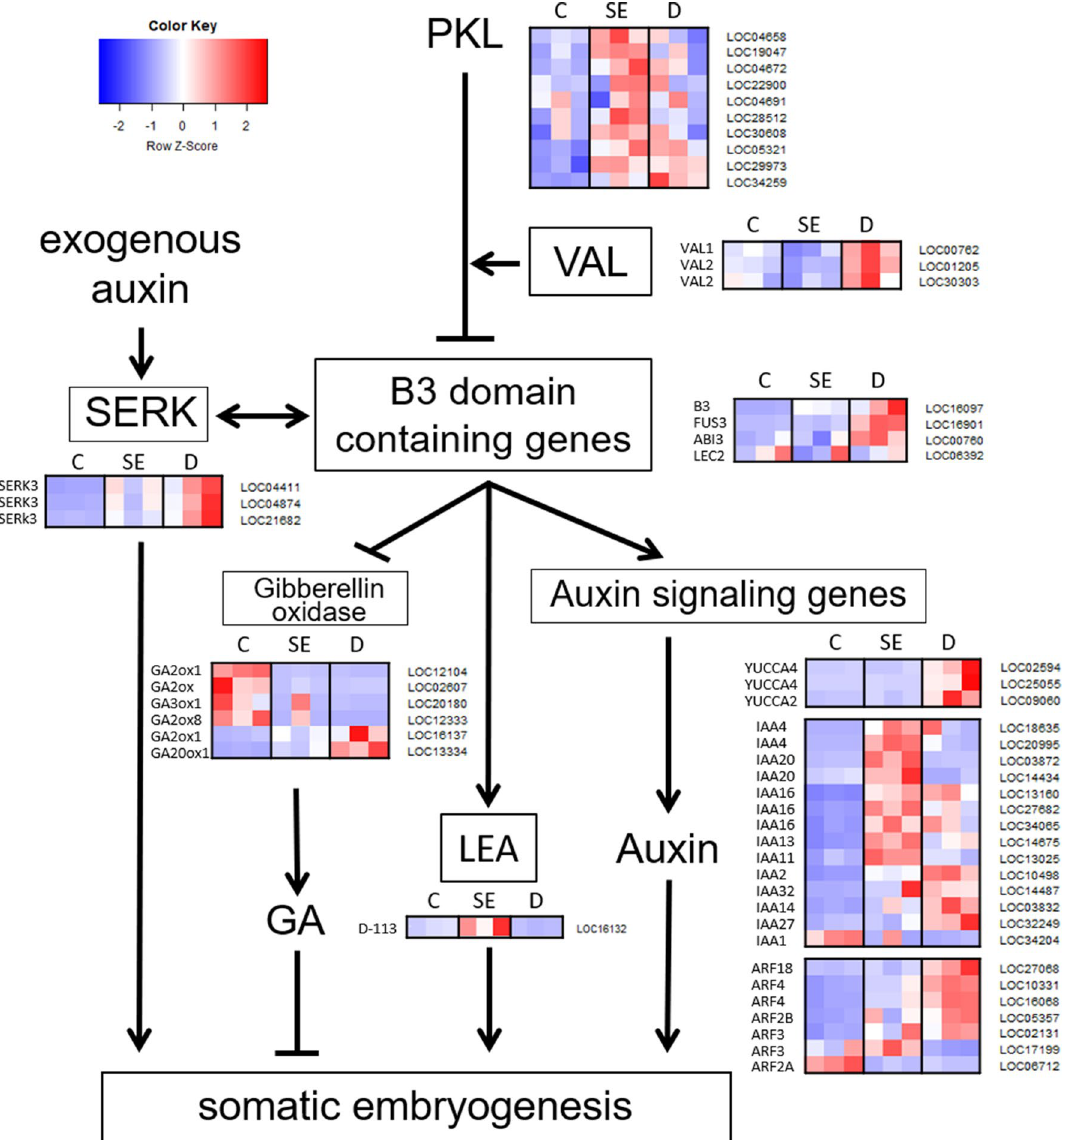
Figure 6. Expression level of Tilia amurensis genes involved in somatic embryogenesis. Colors represent row- scaled TMM-normalized TPM